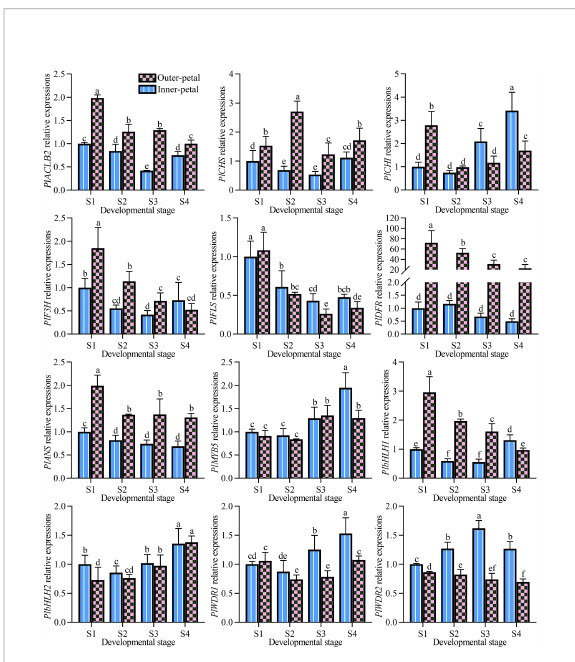
FIGURE 1 Expression pattern analysis of structural and regulatory genes related to anthocyanin biosynthesis pathway in P. lacti fl ora red outer-petals and yellow inner-petals from S1 to S4. S1, unfold- petal stage; S2, soft-bud stage; S3, initial- fl owering stage; S4, full- fl owering stage. The values represent the means ± SDs, and different letters indicate signi fi cant differences ( P <